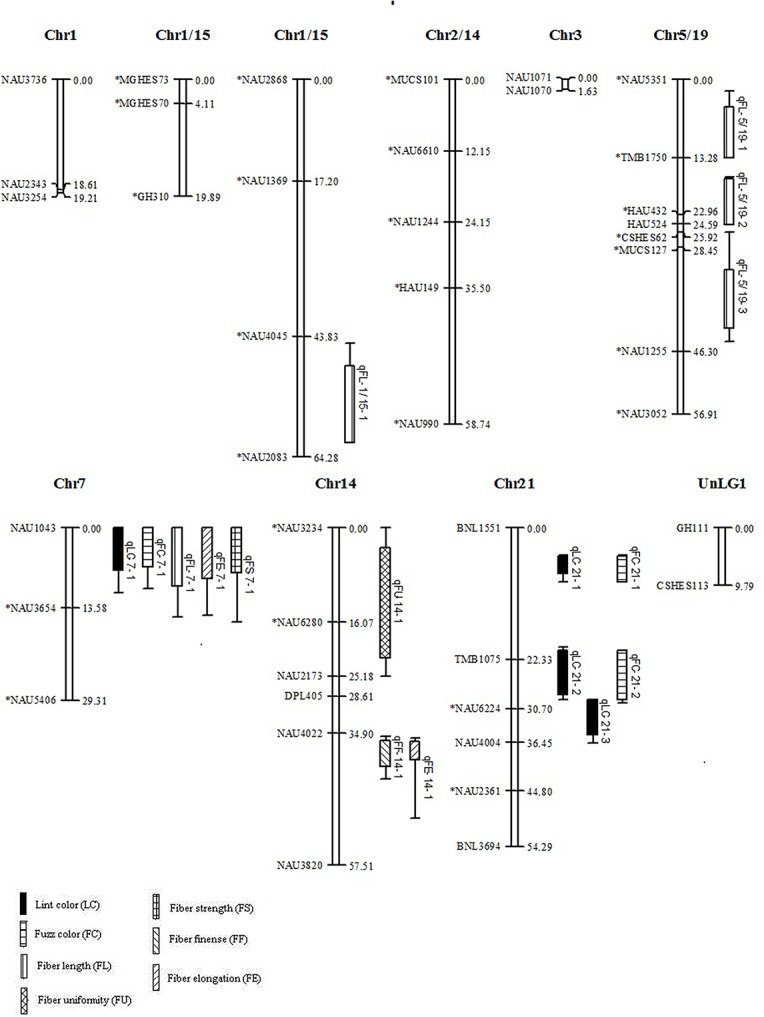
Linkage map from F2 of Zong128 × Liao96-23-30 population.Linkage groups that could not be assigned to a chromosome were given the preliminary names UnLG1. Bars and lines on the right-hand side of the linkage groups show the QTL likelihood intervals. Map distances in centimorgans (cM) are indicated on the left-hand side of the linkage groups. LC, lint color; FC, fuzz color; FL, fiber length; FU, fiber uniformity; FF, micronaire; FE, fiber elongation; FS, fiber strength; *Indicates distorted markers.